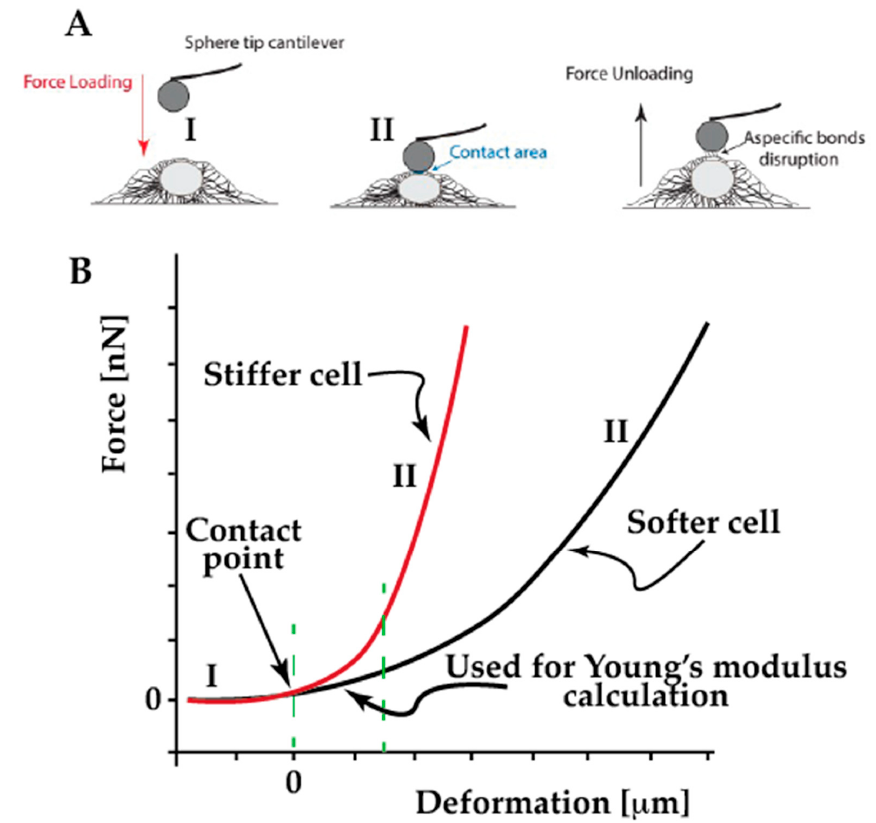
Figure 2. ( A ) Schematic representation of the AFM single cell force spectroscopy experiment. The AFM cantilever is lowered until it touches the cell, then the pulling force is recorded during loading and unloading. ( B ) Force–deformation curve during cell loading cycle, the cell (I-red) is stiffer than cell (II-black).